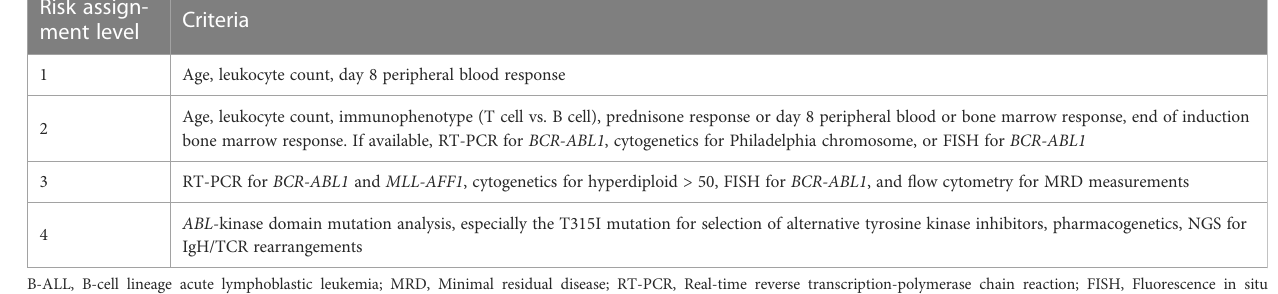
TABLE 2 Risk assignment strati fi cation of